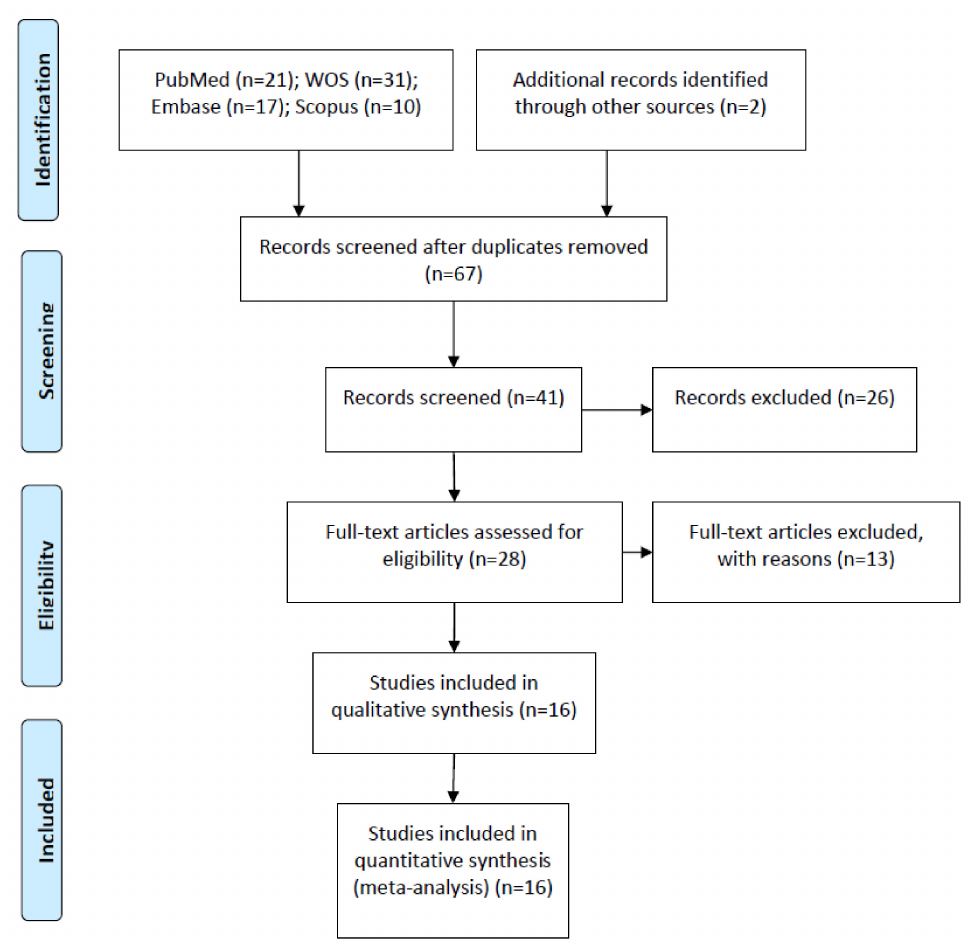
Figure 1. Preferred Reporting Items for Systematic Reviews and Meta-Analyses (PRISMA) flow diagram. Table 1. Assessment of methodological quality according to the Jadad